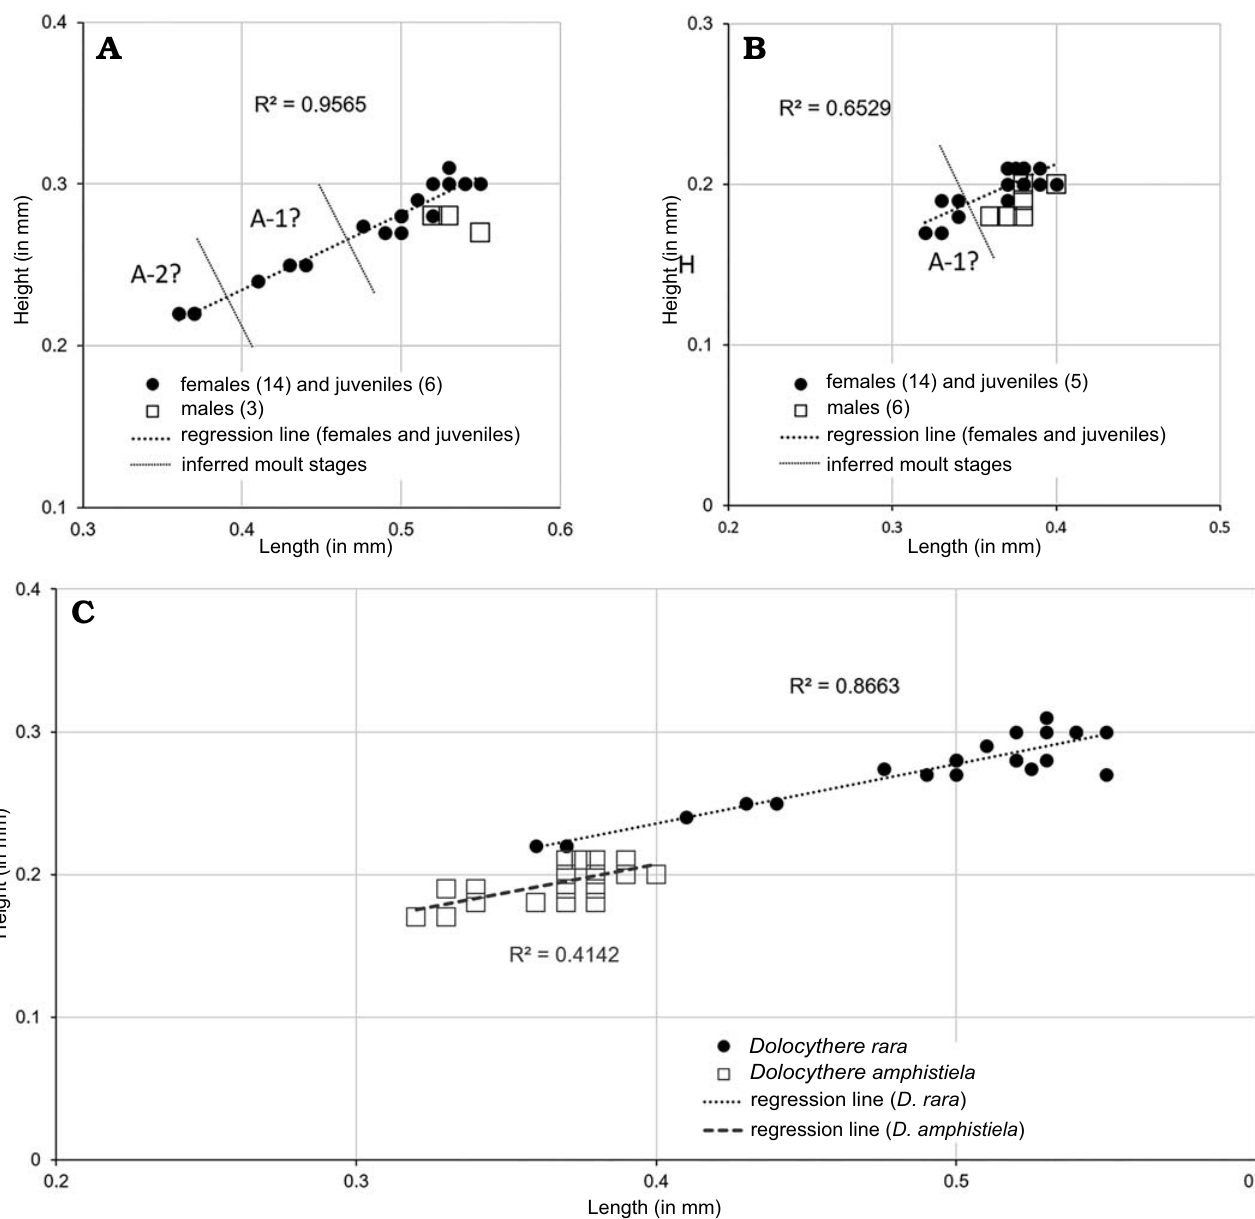
Fig. 19. Length versus height plots for Dolocythere rara Mertens, 1956 ( A ) and Dolocythere amphistiela sp. nov. ( B ), comparison ( C ). A-1, A-2, estimated growth (moult)